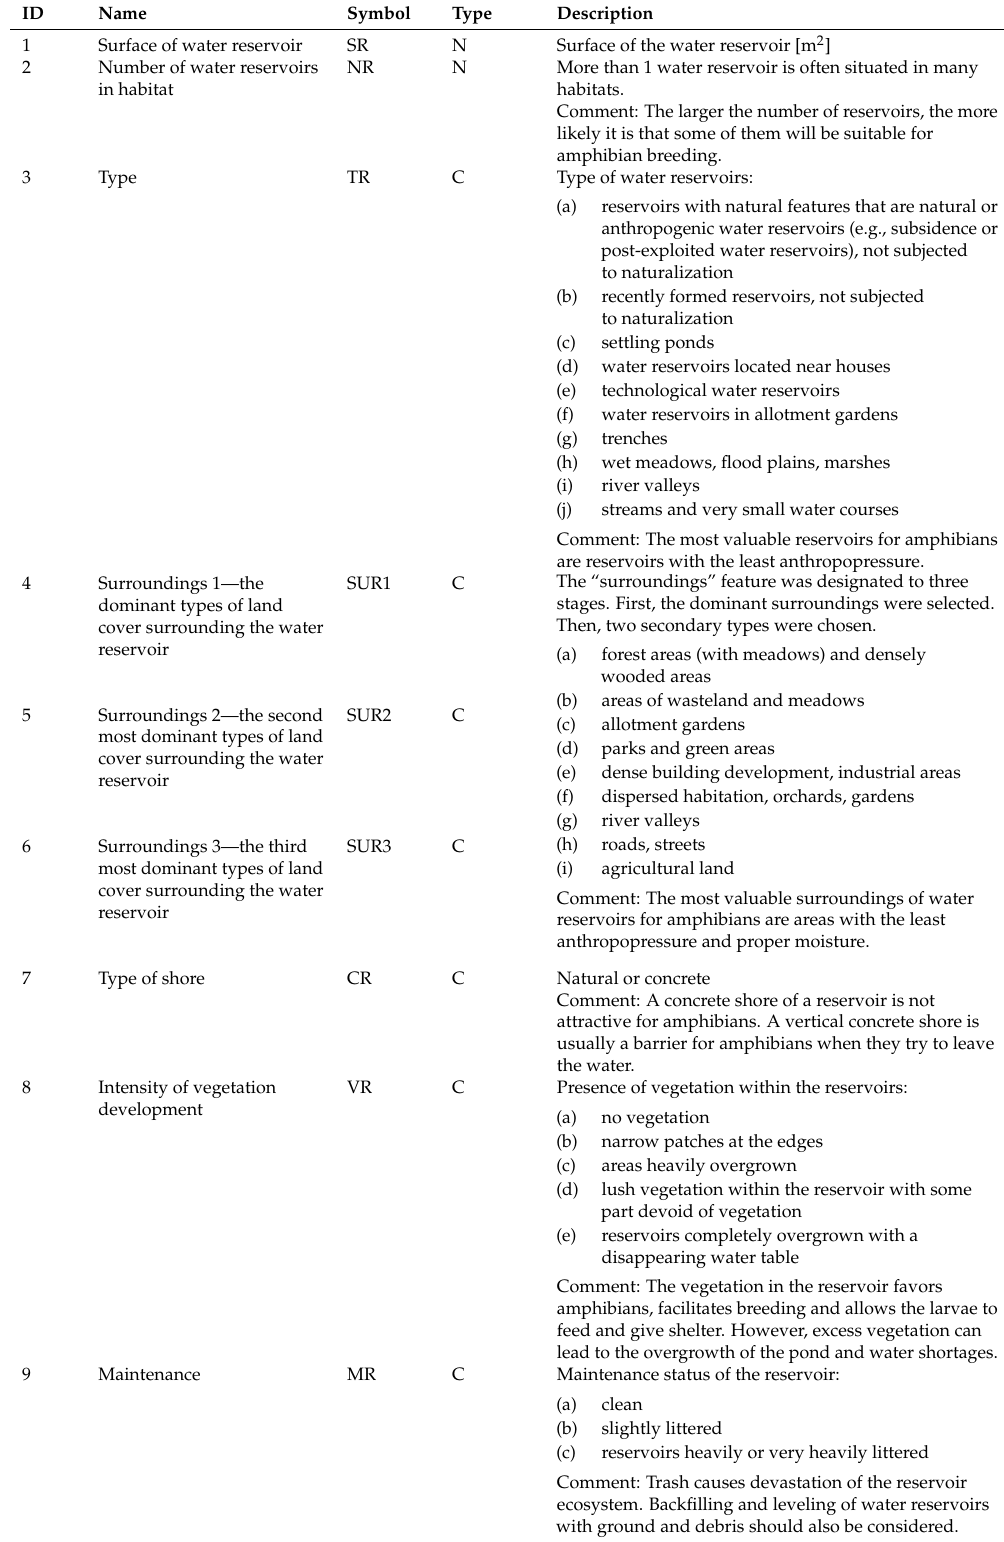
Table 1. Features and its properties used to assess amphibian